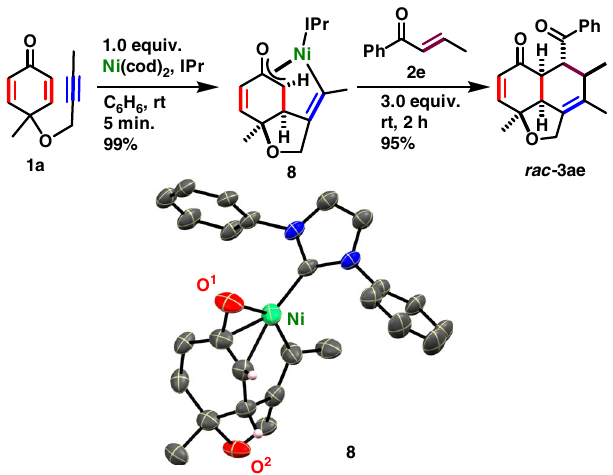
Fig. 5 Stoichiometric reaction with 1a . Isolated yield of 8 and rac - 3ae are given. The molecular structure of η 3 -cyclohexadienyl Ni-complex 8 is disordered and one of the disordered structure is depicted for simplicity with thermal ellipsoid at 30% probability level. i Pr groups and hydrogen atoms (except those bound to the chiral carbons) are omitted for